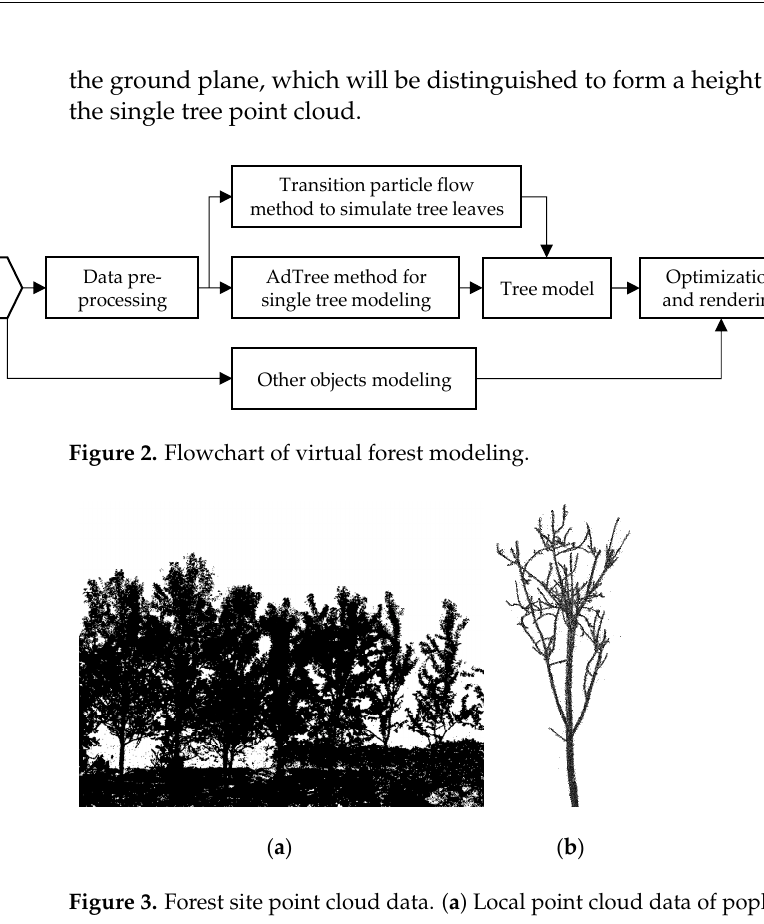
Figure 3. Forest site point cloud data. ( a ) Local point cloud data of poplar plantation. ( b ) Point cloud data of tree branches and trunks.